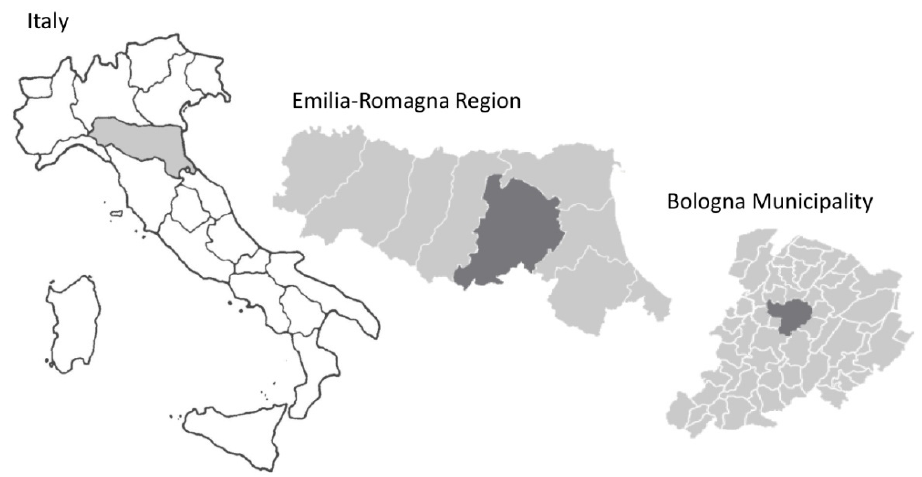
Figure 2. Bologna Municipality (Italy) location.